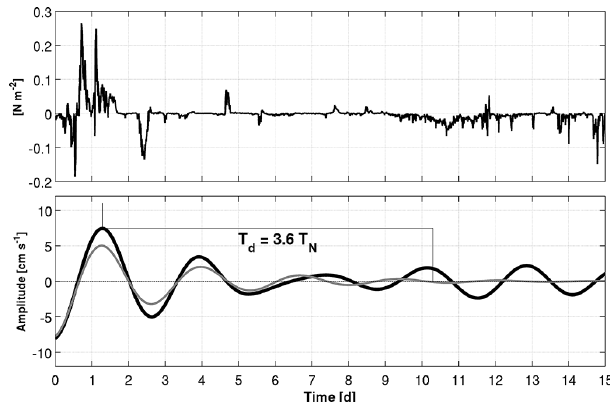
Figure 10. Damping signal in currents during a period of weak winds ( W >1) at Cochamo (16 to 24 August 2008). The band-pass currents at 3m depth (black line) were compared with a damping os- cillatory curve x(t) = Ae ( − kt) cos (ωt + φ) (gray line). The damping time ( T d ) was 3.6 times longer than the fundamental internal period ( T N )